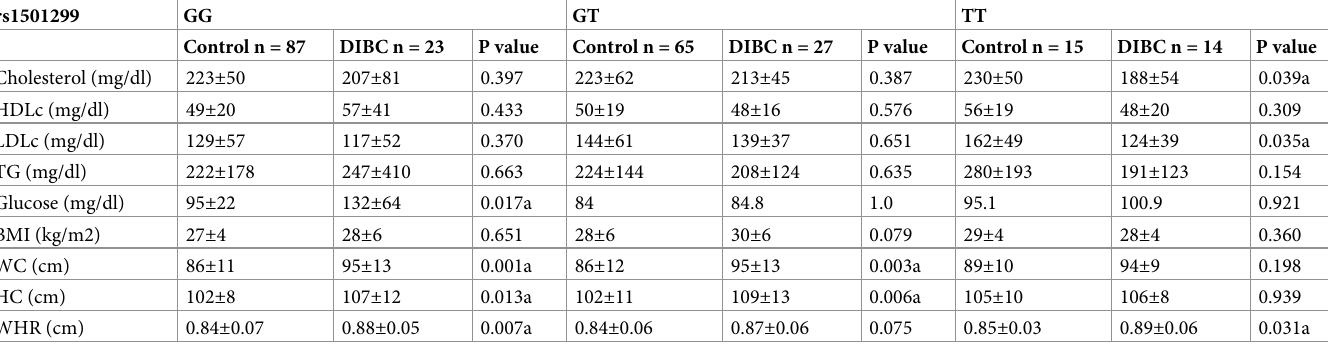
Table 4. Comparison of corporal composition measures and biochemical determinations with rs1501299 SNP.